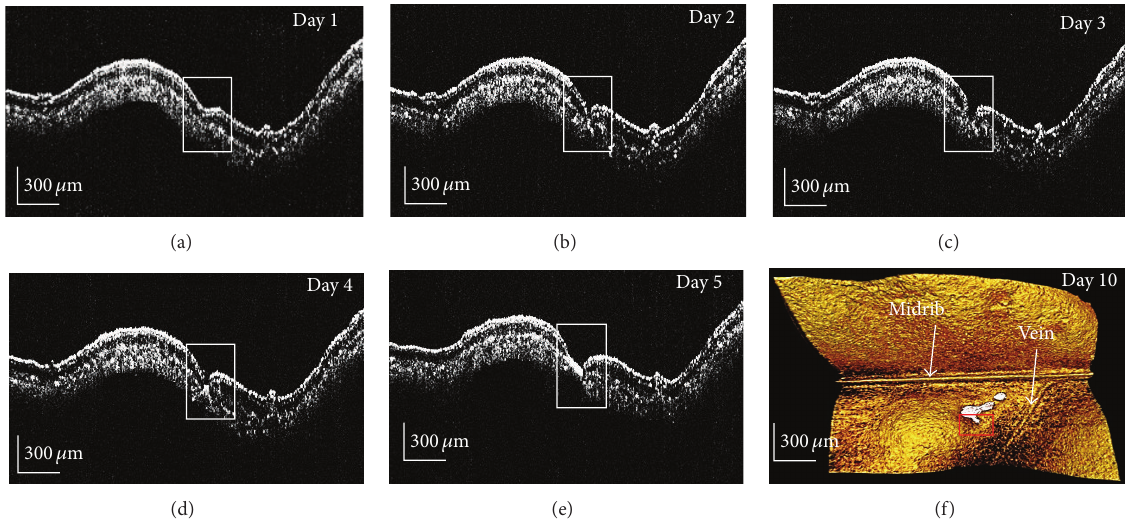
Figure 3: 2D and 3D SD-OCT images. 2D images of disease progression and growth are illustrated through image (a) to image (e) which were taken on consecutive days from day 1 to day 5; (f) is a 3D image of the same leaf showing the area scanned highlighted with red box, and midrib and vein of leaf are indicated in the 3D image taken on day 10.